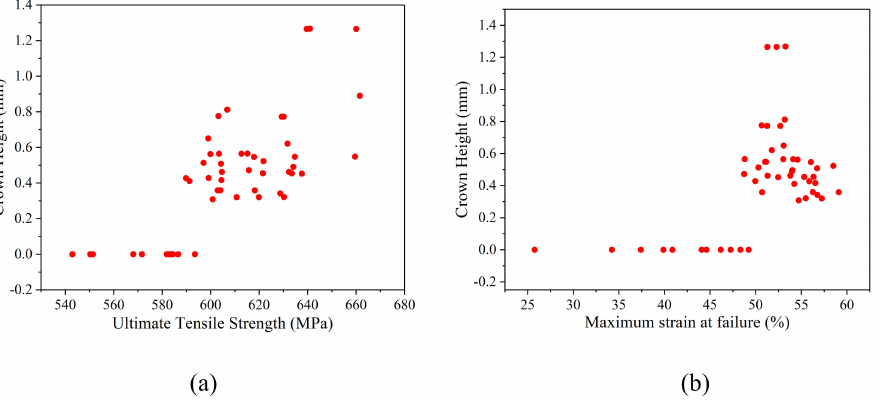
Figure 17. Effect of CH for the welds made heterogeneously on the ( a ) UTS and ( b ) ε . Welds having CH = 0 were found to have a significantly lower UTS and ε than those that had a positive CH